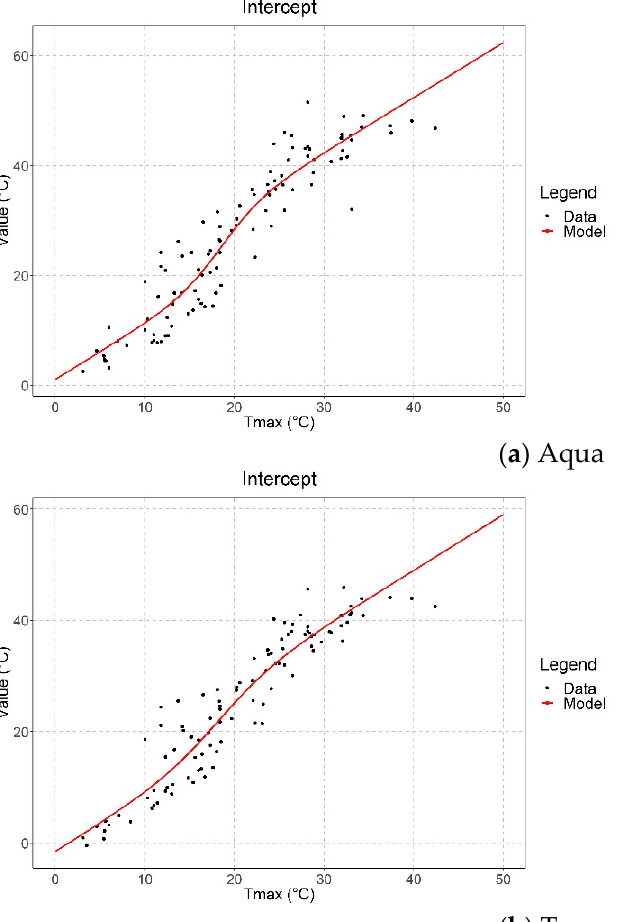
Table 2. Model parameters—Terra.